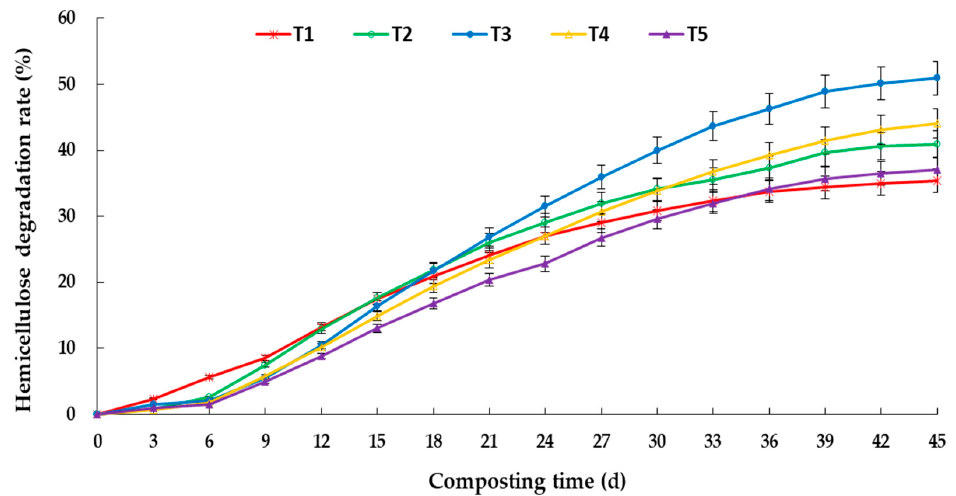
Figure 4. Changes in hemicellulose degradation rate during composting of corn straw and cow dung under different C/N ratios.